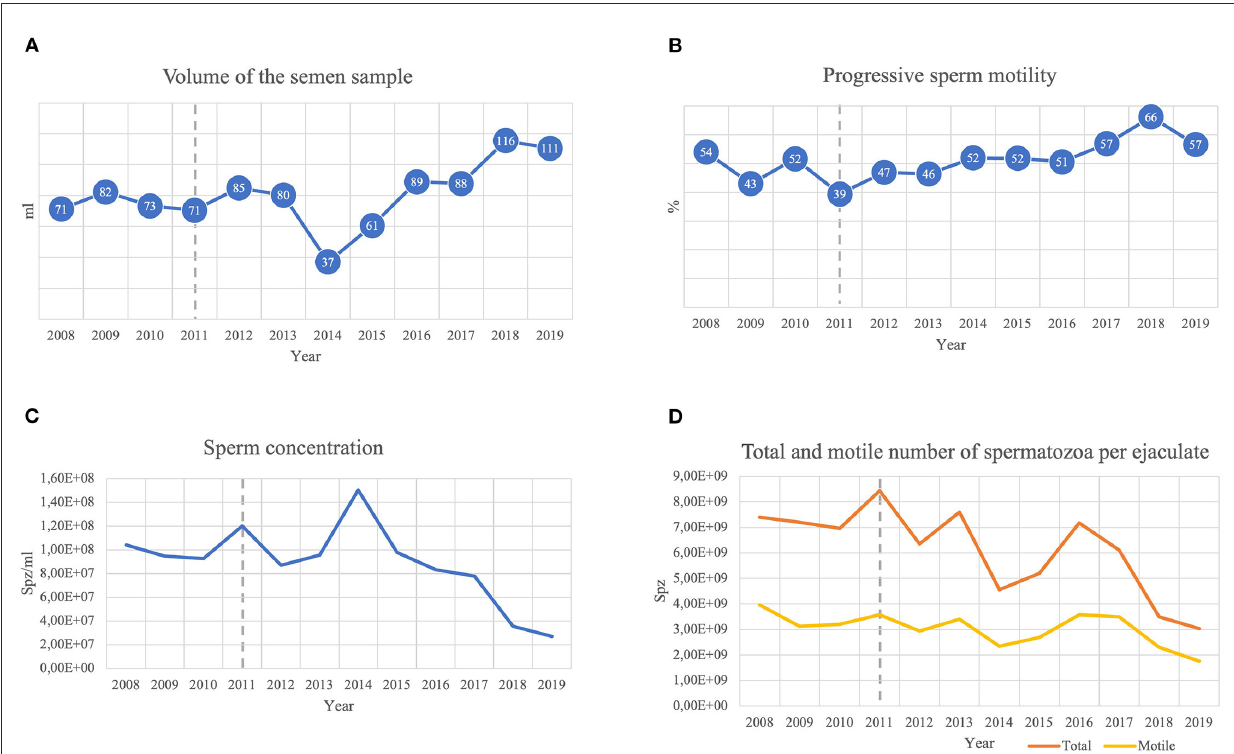
FIGURE1 Stallion reproductive parameters collected during 2008–2019: (A) total semen sample volume collected; (B) progressive sperm motility; (C) sperm concentration; (D) total and motile number of spermatozoa per ejaculate. An abrupt decrease in the volume of the semen sample associated with a peak in total sperm concentration was noted in 2014, although the numbers of total and motile spermatozoa present were reduced. In 2018 and 2019, the highest values of semen volume were registered, accompanied by high values of progressive motility. Nevertheless, sperm concentration decreased from 2015 to 2019, presenting a decrease in the number of total and motile spermatozoa that reached minimal values in 2019. - - Lesion’s clinical diagnosis.